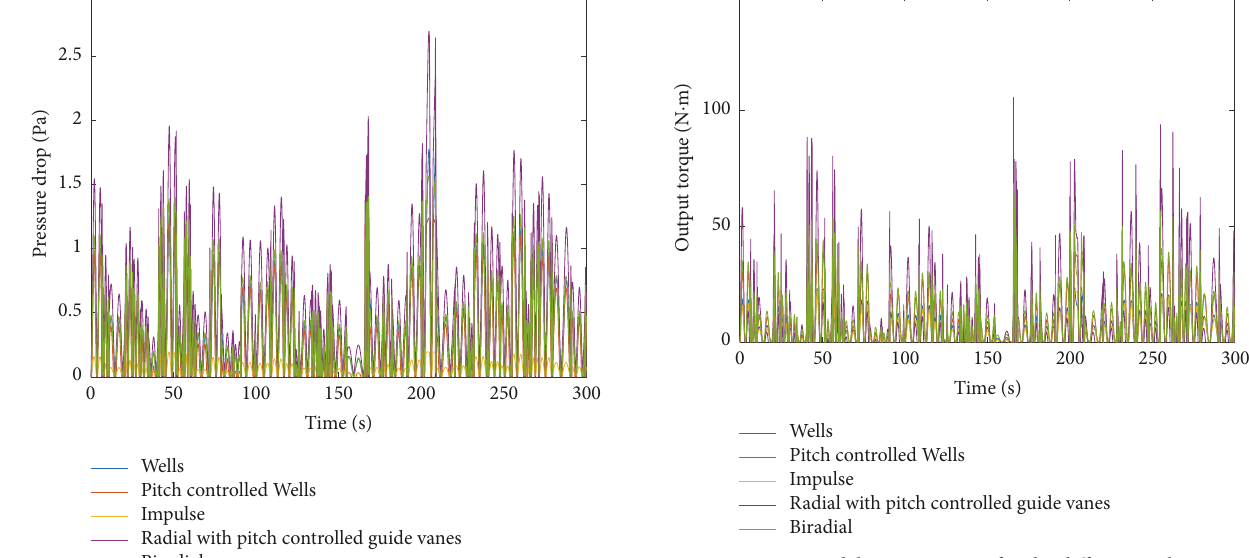
Figure 12: Model torque output for the different